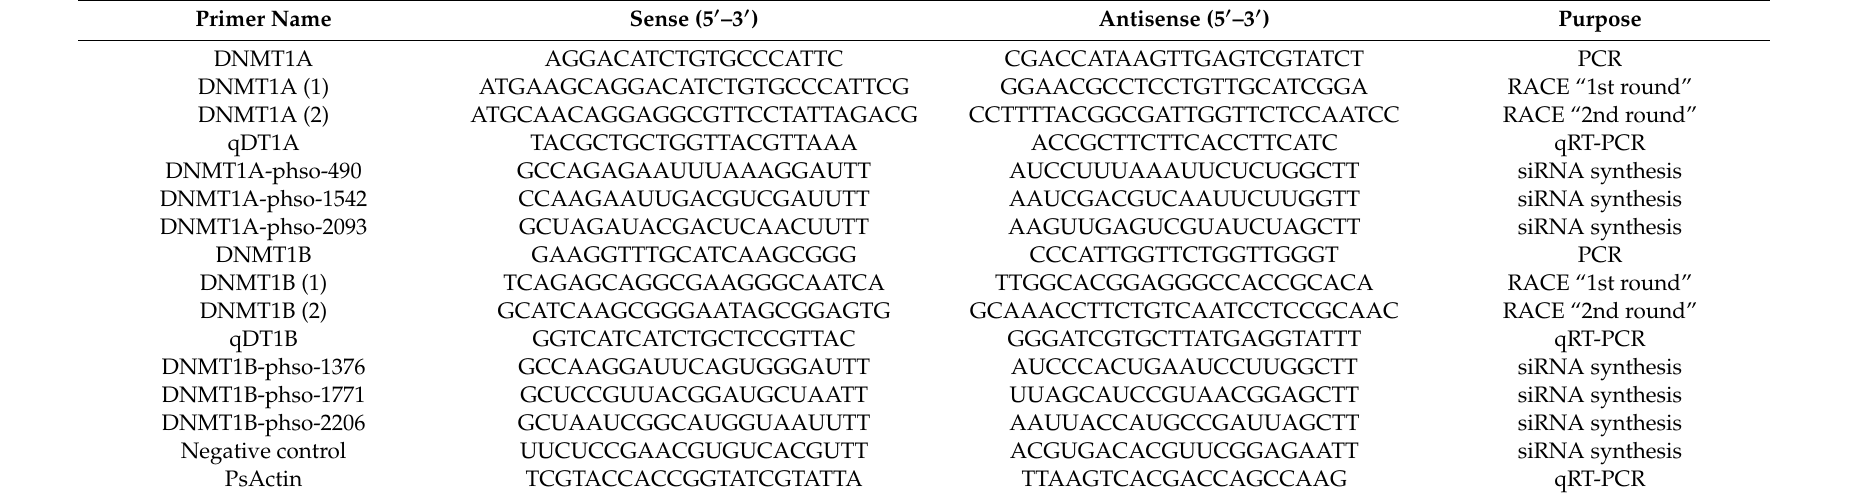
Table 1. All primer pairs used in the present